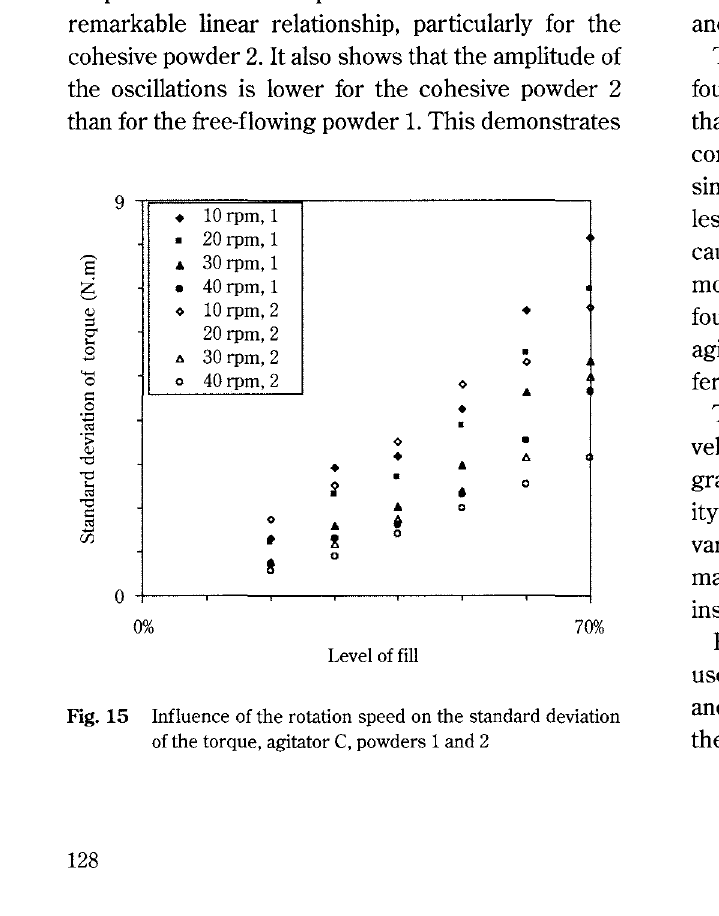
Fig. 15 Influence of the rotation speed on the standard deviation of the torque, agitator C, powders 1 and 2